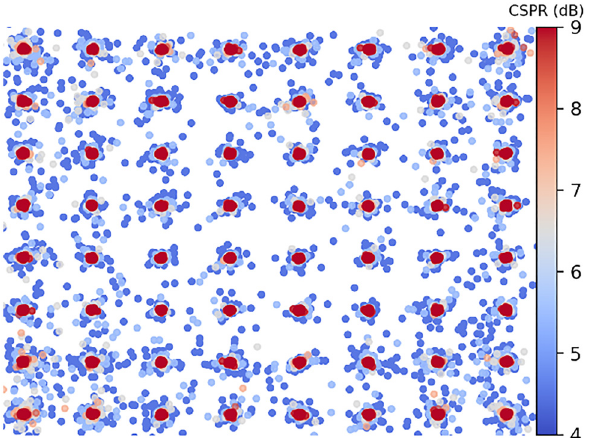
Figure 3: Reconstruction of a 64 QAM signal at different CSPR values. Lower CSPR values (in blue) show large errors, as reconstruction becomes more accurate at higher CSPRs (in